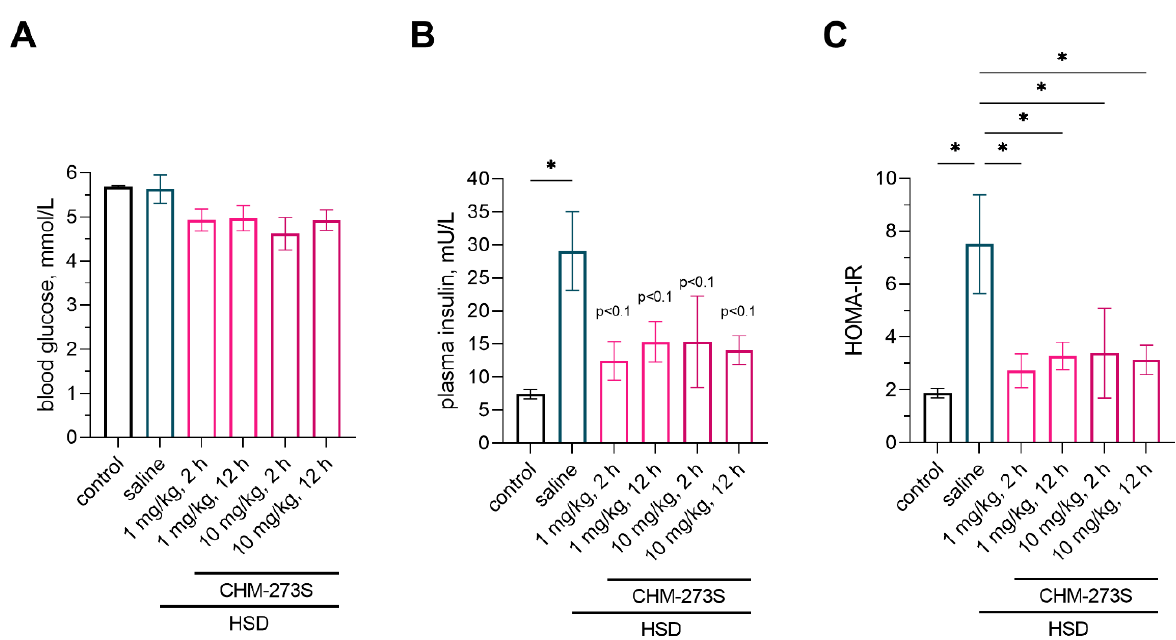
Figure 4. Fasting blood glucose, insulin, and homeostatic model assessment for insulin resistance